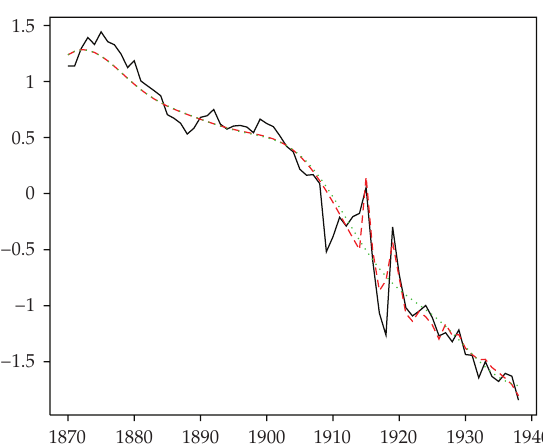
Figure 3: Plots of estimated curves. The solid line represents y ; the dotted lines are the estimates of y ; the dashed lines are the estimated curve (cid:11) α .